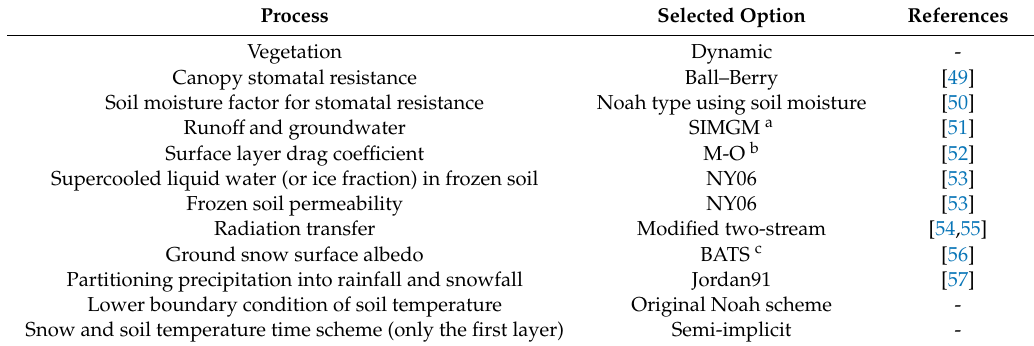
Table 1. Noah Land Surface Model with multiparameterization (Noah-MP) v3.6 options of physical parameterization schemes used in this study. (See Niu et al. [28] for additional